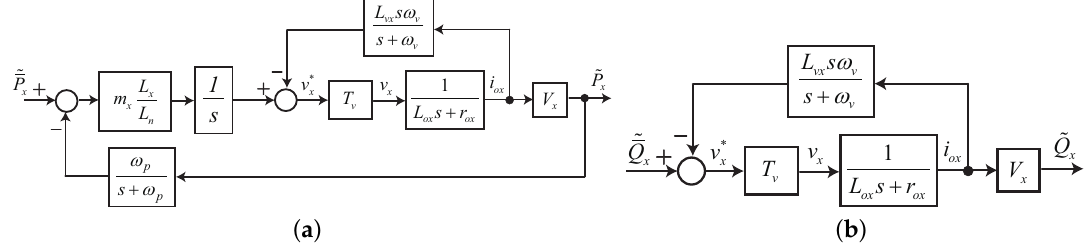
Figure 7. Equivalent block diagram of Figure 6: ( a ) real power control; ( b ) reactive power control. The real power control transfer function is derived from Figure 7a